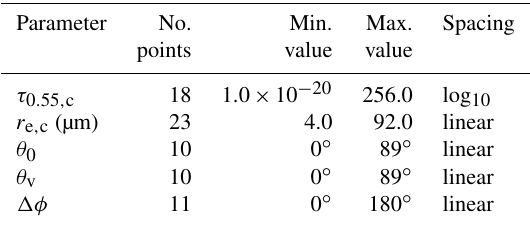
Table 2. The dimensions of the ORAC LUTs used in the ice cloud retrieval. Note that not all LUTs are functions of all variables (for instance, atmospheric transmission terms are functions of a single zenith angle only). Parameter No. Min. Max.